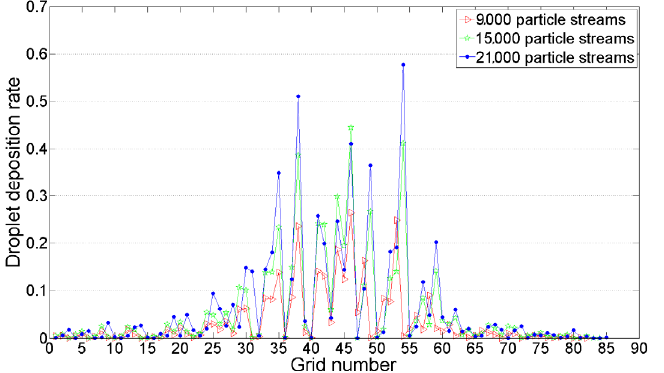
Figure 13 . Droplet deposition rate within the same grid with different number of particle